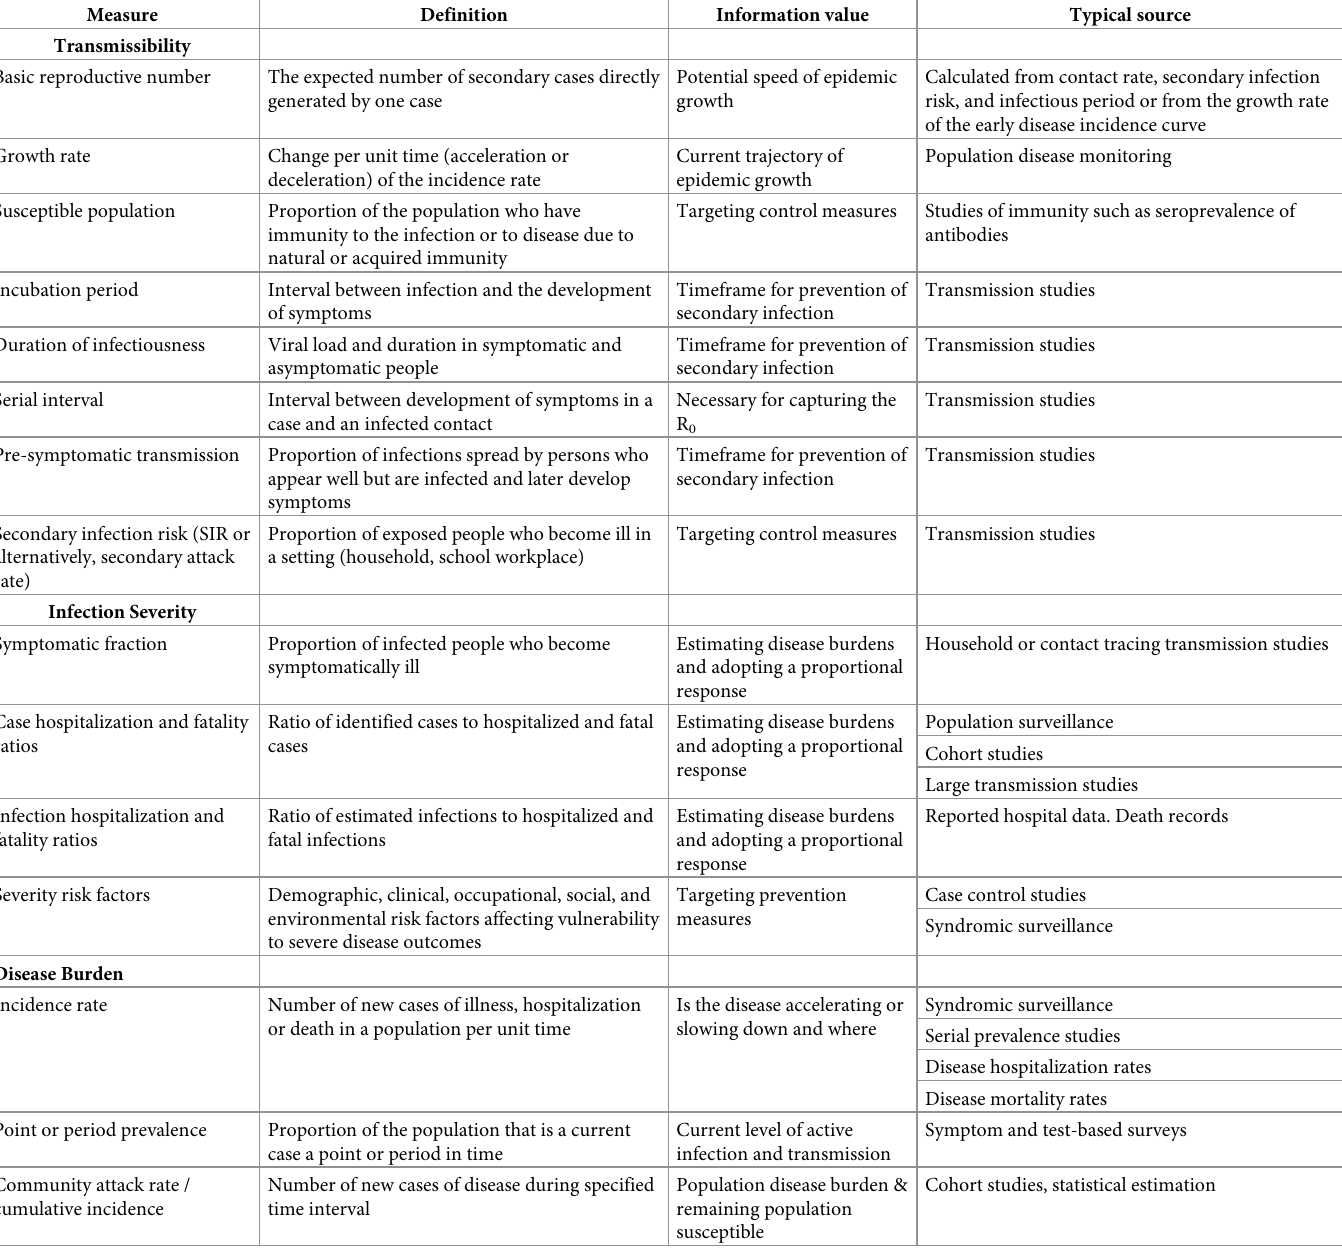
Table 1. Epidemiological data required for managing emerging respiratory virus